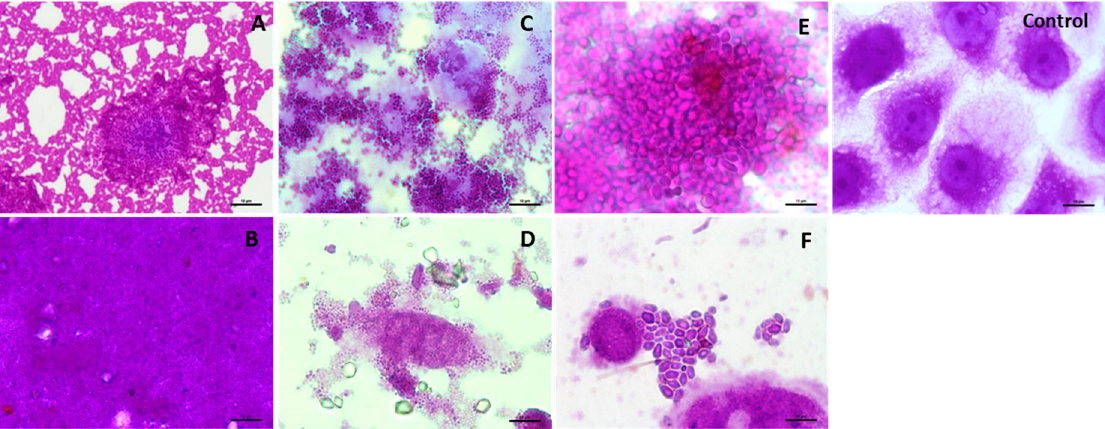
Figure 8 . Selected microphotographs showing adherence to Caco-2 cells of: L. brevis Ł OCK 0983 – without ( A ) Figure 8. Selected microphotographs showing adherence to Caco-2 cells of: L. brevis ŁOCK 0983–without and with ( B ) hydrolysate; S. aureus ATCC 25923 – without ( C ) and with ( D ) hydrolysate; C. albicans ATCC 10231 ( A ) and with ( B ) hydrolysate; S. aureus ATCC 25923–without ( C ) and with ( D ) hydrolysate; C. albicans without ( E ) and with ( F ) hydrolysate (× 400, Nikon Eclipse, Japan). ATCC 10231 without ( E ) and with ( F ) hydrolysate ( × 400, Nikon Eclipse,